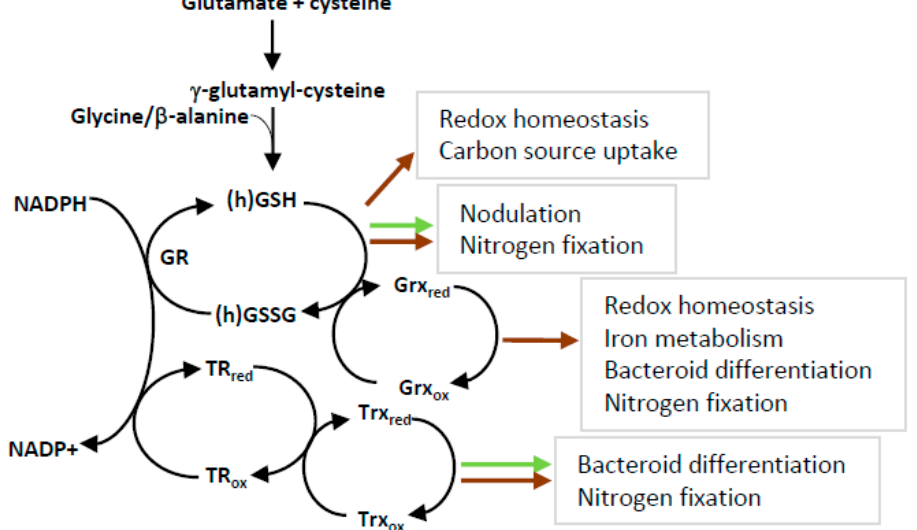
Figure 2. An overview of the physiological importance of Trx and Grx networks in rhizobium–legume symbiosis. Redox networks of glutaredoxin and thioredoxin systems in the two symbiotic partners is shown. The roles of (h)GSH, Grxs, and Trxs (grey squares) are indicated for bacteria (brown arrow) and for plants (green arrow). See text for details.